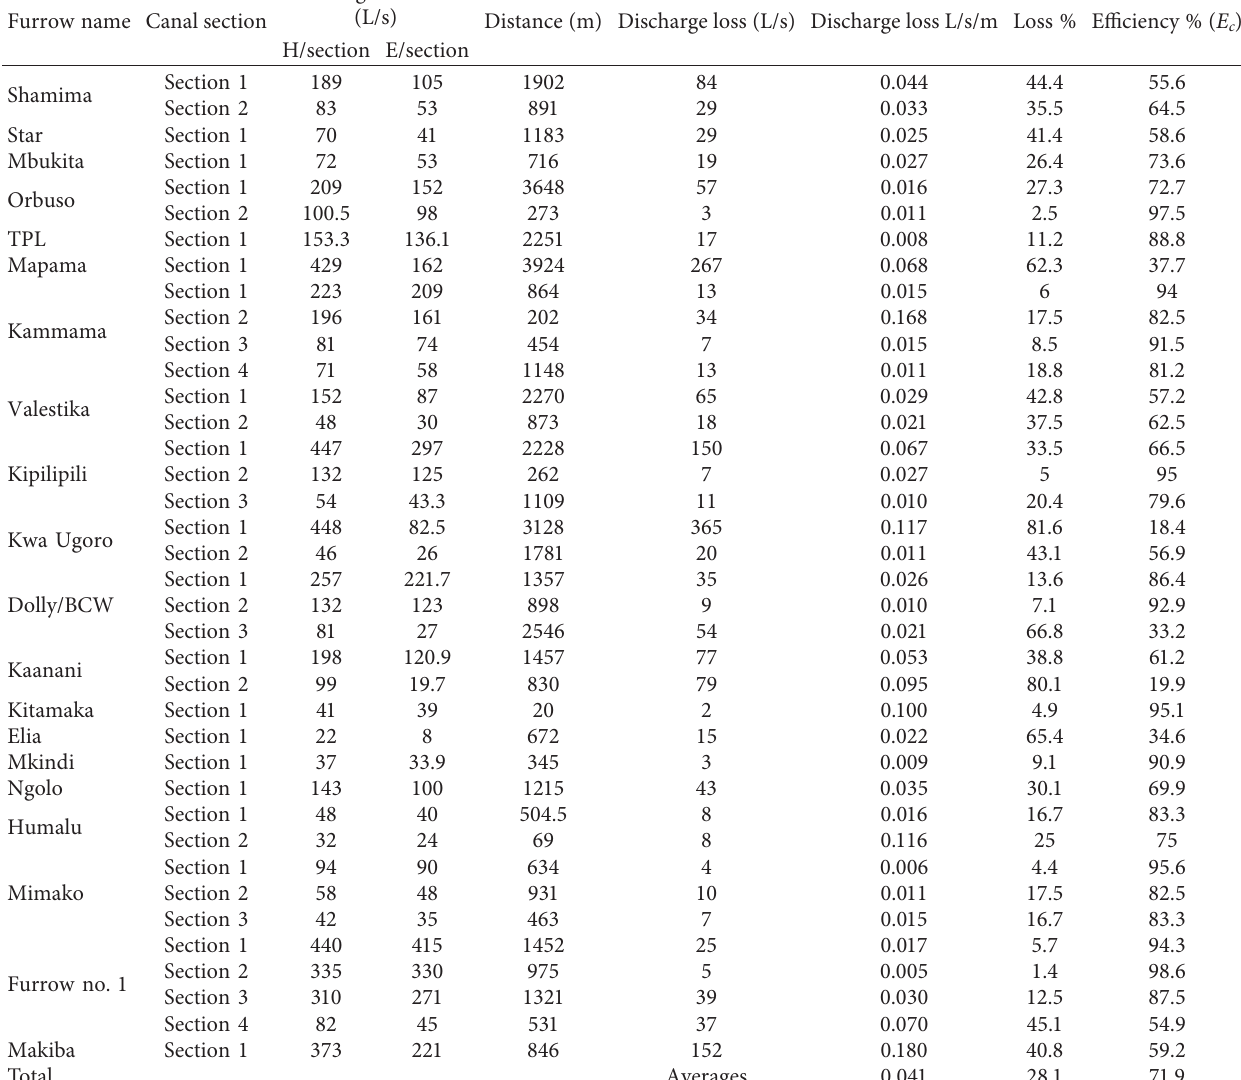
Table 2: Conveyances efficiencies.